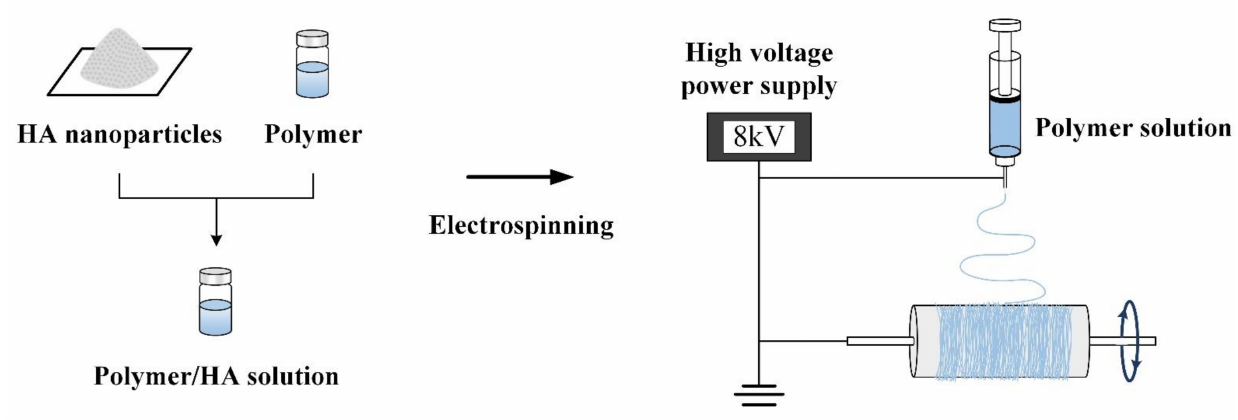
Figure 3. Fiber-based membranes were prepared by electrospinning simulated polymer compos- ite